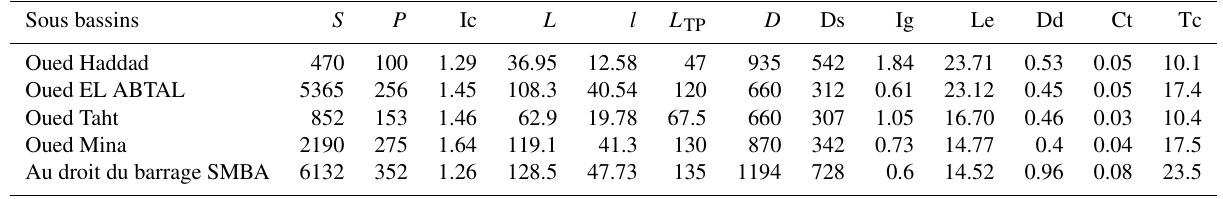
Tableau 1. Récapitulatif des bassins versants. Sous bassins